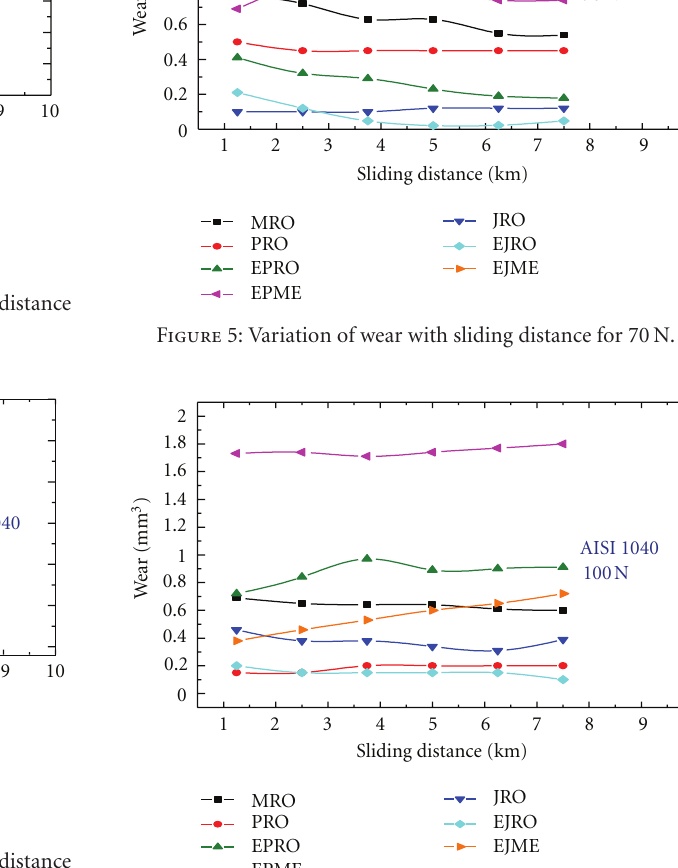
Figure 4: Variation of coe ffi cient of friction with sliding distance for 200 N.